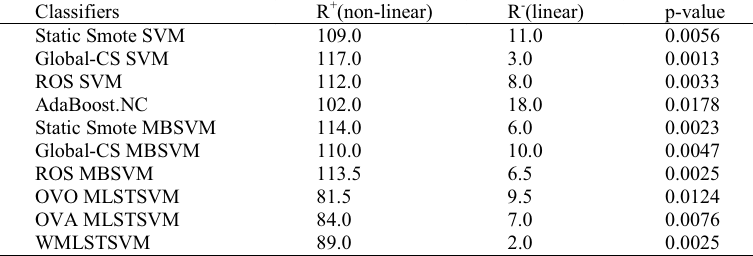
Table 5. Wilcoxon test for the comparison between linear and non-linear classifiers